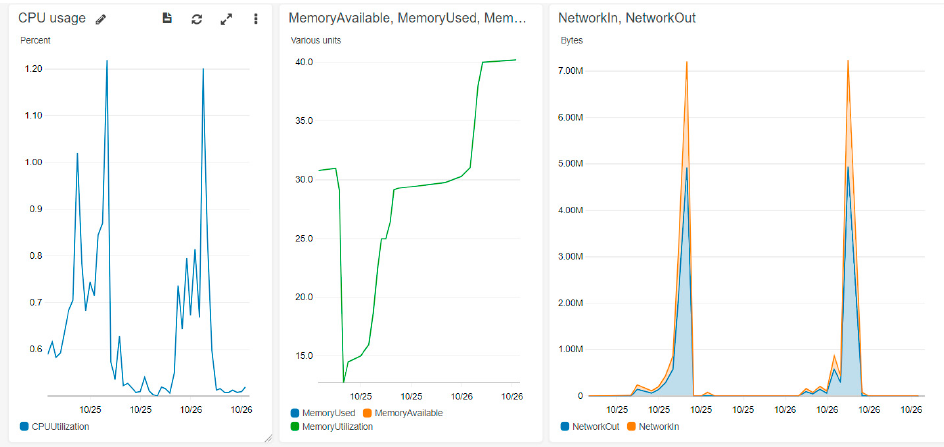
Figure 6. CPU, memory, network measurements during the tests.